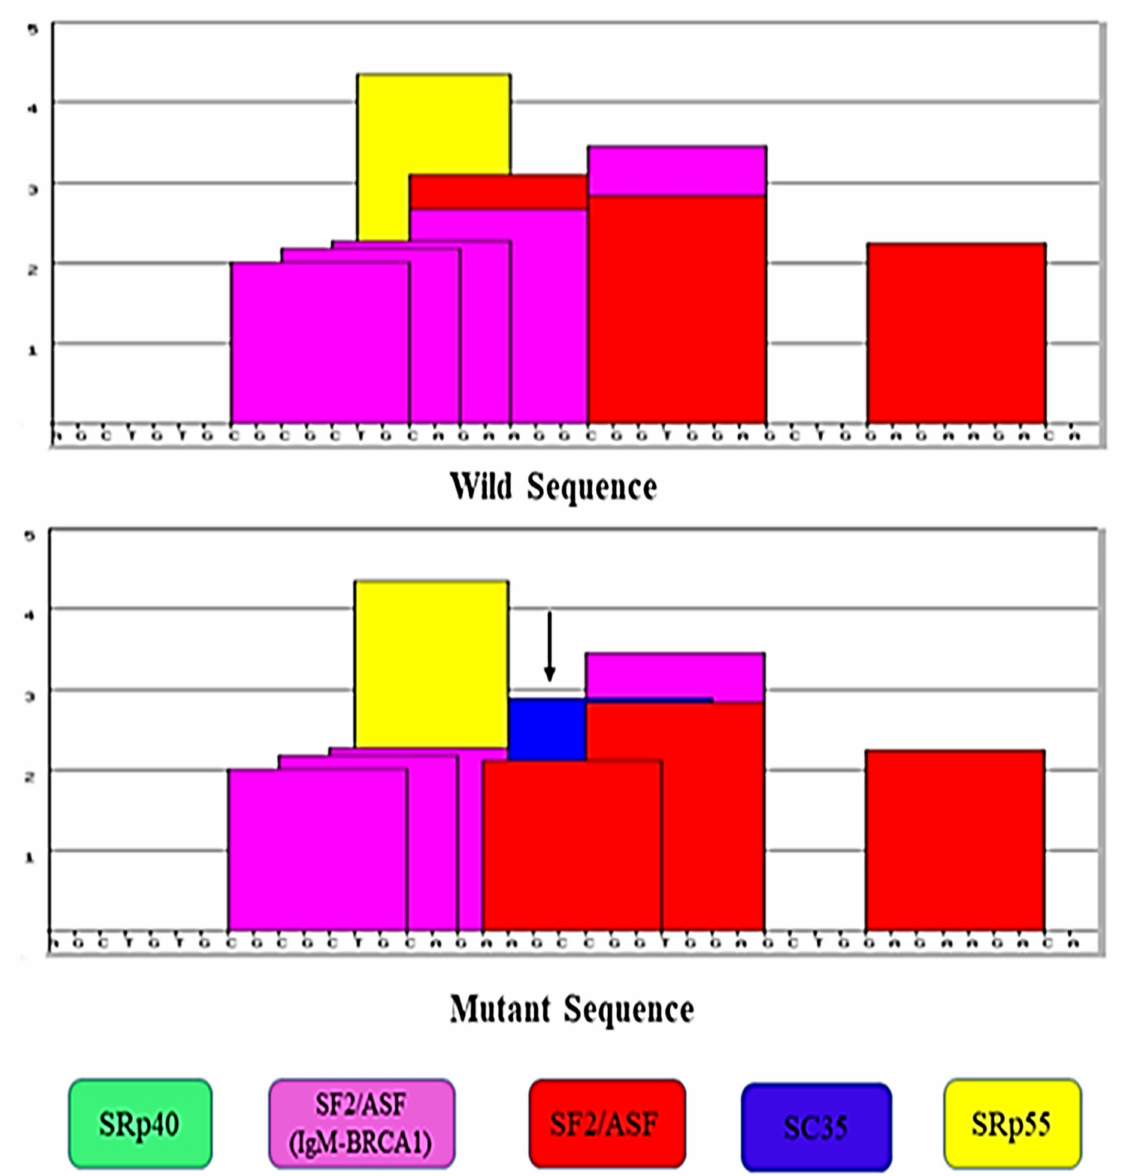
Figure 4. Effect of genetic variation on the Exonic Splicing Enhancers (ESEs) according to ESE prediction tool. ESE finder enables to recognize the potential ESE sites. The elevation of the colored bars represents the motif scores, and the girth of the bars indicates the length of the motif. Bars in red, yellow, blue, purple, and green indicate potential binding sites for serine-arginine (SR) proteins SF2/ASF, SRp55, SC35, SF2/ASF (IgM-BRCA1), and SRp40, respectively. Upper Panel signifies the ESE analysis of normal sequence and lower panel denotes the ESE sequence with effect on splice